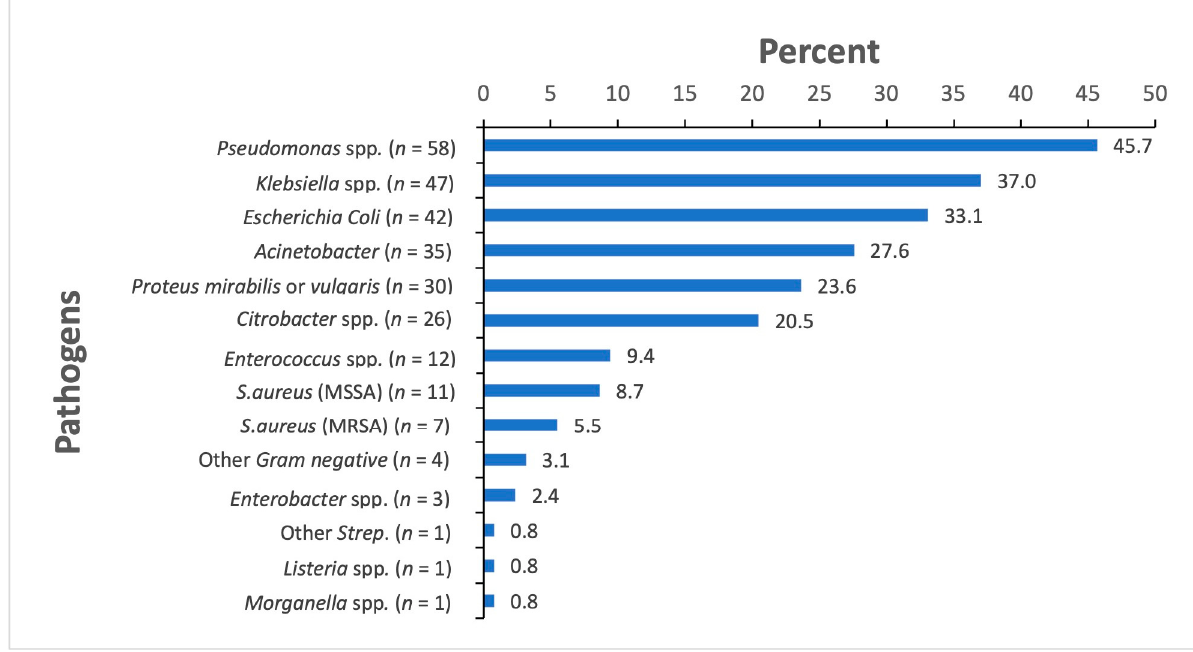
Figure 3. The bacteria isolated in wound swabs, n = 127. Figure legend: n denotes the number of patients with a bacterial pathogen isolated from wound swabs. Among the Pseudomonas spp. isolates, 74.4% (29/39) showed resistance to the fourth generation cephalosporine cefepime. Furthermore, Pseudomonas spp. isolates were resistant to ceftazidime, amikacin and gentamicin in 69.2% (27/39), 65% (26/40) and 65.9% (29/44) of cases, respectively. For Klebsiella spp., resistance to ceftriaxone/cefotaxime was seen in 95.6% (44/46) of the isolates, while resistance to amoxicillin/clavulanic acid and imipenem were found in 51.7% (15/29) and 8.5% (4/47) of isolates, respectively. E. coli isolates were resistant to ceftriaxone/cefotaxime in 87.5% (35/40), whereas carbapenem resistance was rarely observed (2 isolates). Almost half of all E. coli isolates were resistant to amoxi- cillin/clavulanic acid (45.5%,15/33) and more than half were resistant to ciprofloxacin (52.8%, 19/36). Acinetobacter spp. were isolated in 27.6% (35/127) of positive wound swab cultures. Here, 45.5% (15/33) of isolates were resistant to carbapenems, 67.9% (19/28) were resistant to piperacillin/tazobactam and 77.4% (24/31) were resistant to fluoroquinolones. Among P. mirabilis or P. vulgaris isolates, 14.3% (4/28) were resistant to carbapenems,